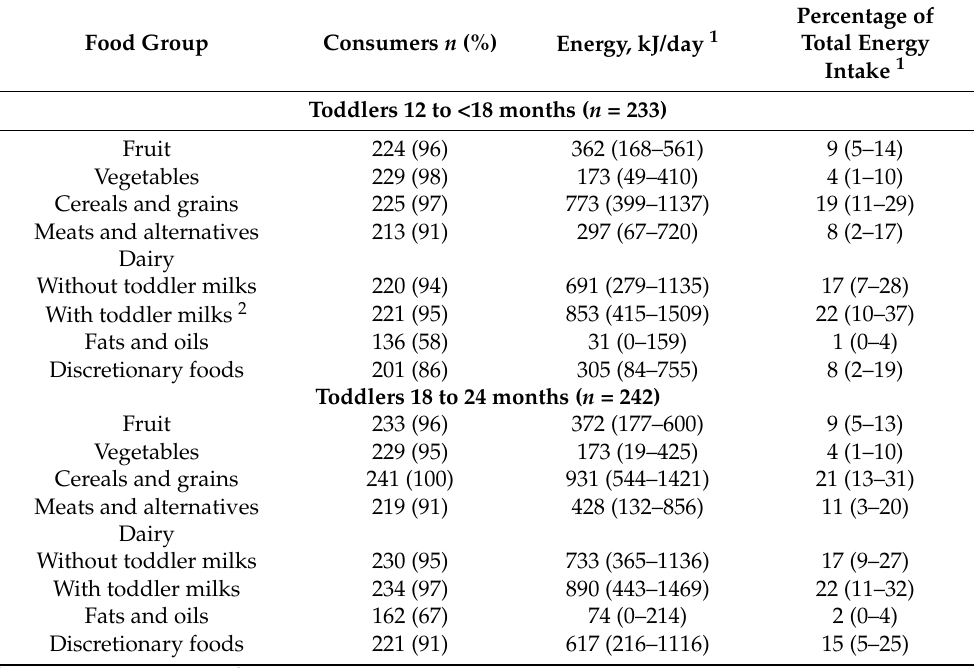
Table 5. Energy and percentage total energy from five food groups and discretionary foods for toddlers stratified by age, OzFITS 2021.